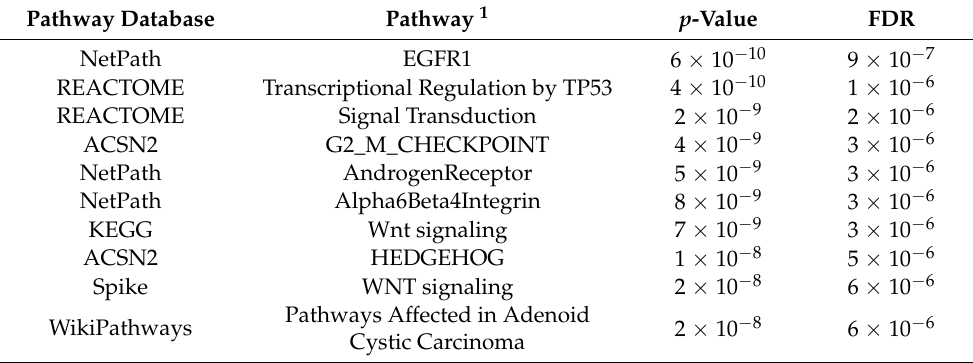
Table 3. Predicted targets of lung oncofetal miRNAs are enriched for members of developmental and cancer-related